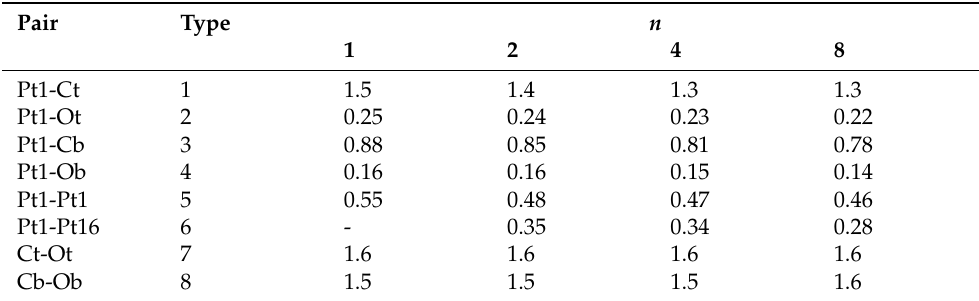
Figure 1. Structure of infinite nano-wire [Pt 3 (CO) 6 ] 82– in a periodic cell, drawn in blue. The energy is minimized with no counterions and the total charge q = − 2. The nano-wire direction is along the z axis (blue). Pt, C and O atoms are represented as ochre, gray and red spheres, respectively. Atomic and bond radii are arbitrary. Bonds are drawn when the distance between atoms is shorter than 2.1 Å. The VMD program [26] is used for all molecular drawings. Table 1. DIs for types of atomic pairs as indicated in Figure 2. Pt1 indicates Pt of the displayed monomer, while Pt16 indicates the closest Pt atom of the nearby monomer in the stack. These values are obtained with no counterions, using the minimal energy configurations obtained with total charge q = − 2 in all